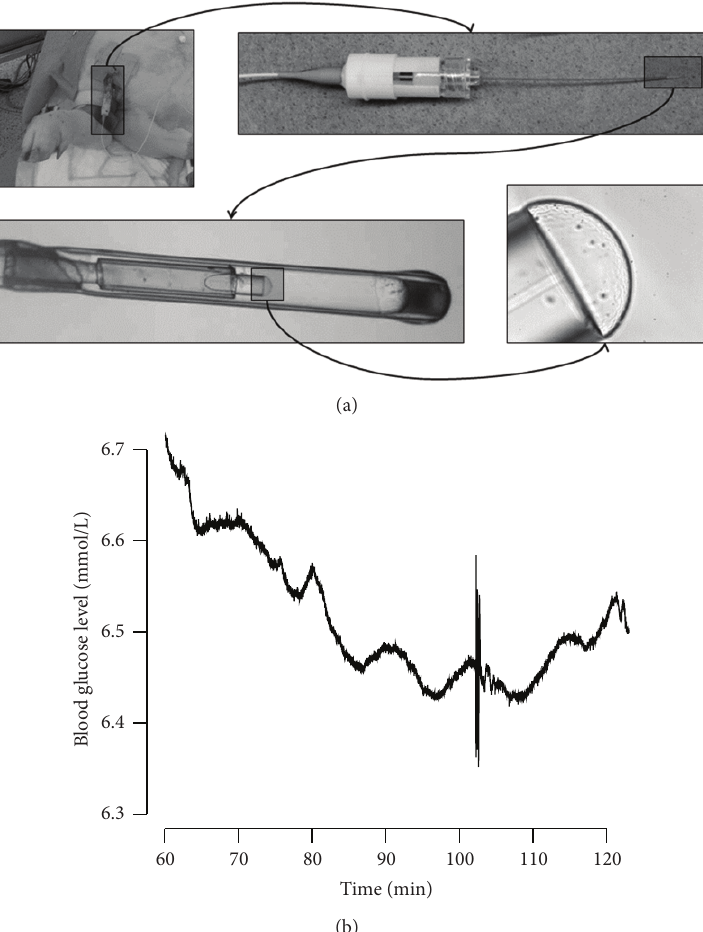
Figure 1: (a) Pictures that show the hydrogel part of the IvS-1 continuous blood glucose monitor prototype at increasing magnification; (b) a classic example of oscillating blood glucose levels with a periodicity of approximately 10 minutes and an amplitude of approximately 0.05 mmol/L (from animal 2, which was only mildly affected by the streptozotocin pretreatment; measurements from 60 to 120 minutes in the actual experiment after IvS-1 stabilization but before the first insulin bolus; artifact seen at 103 minutes).